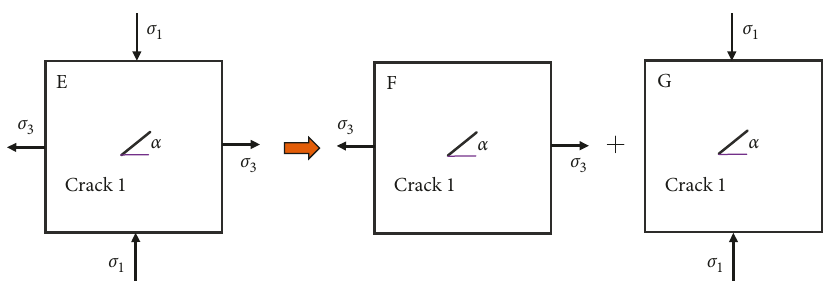
Figure 6: Superposition method of stress state of rock mass with single crack under unloading conditions.